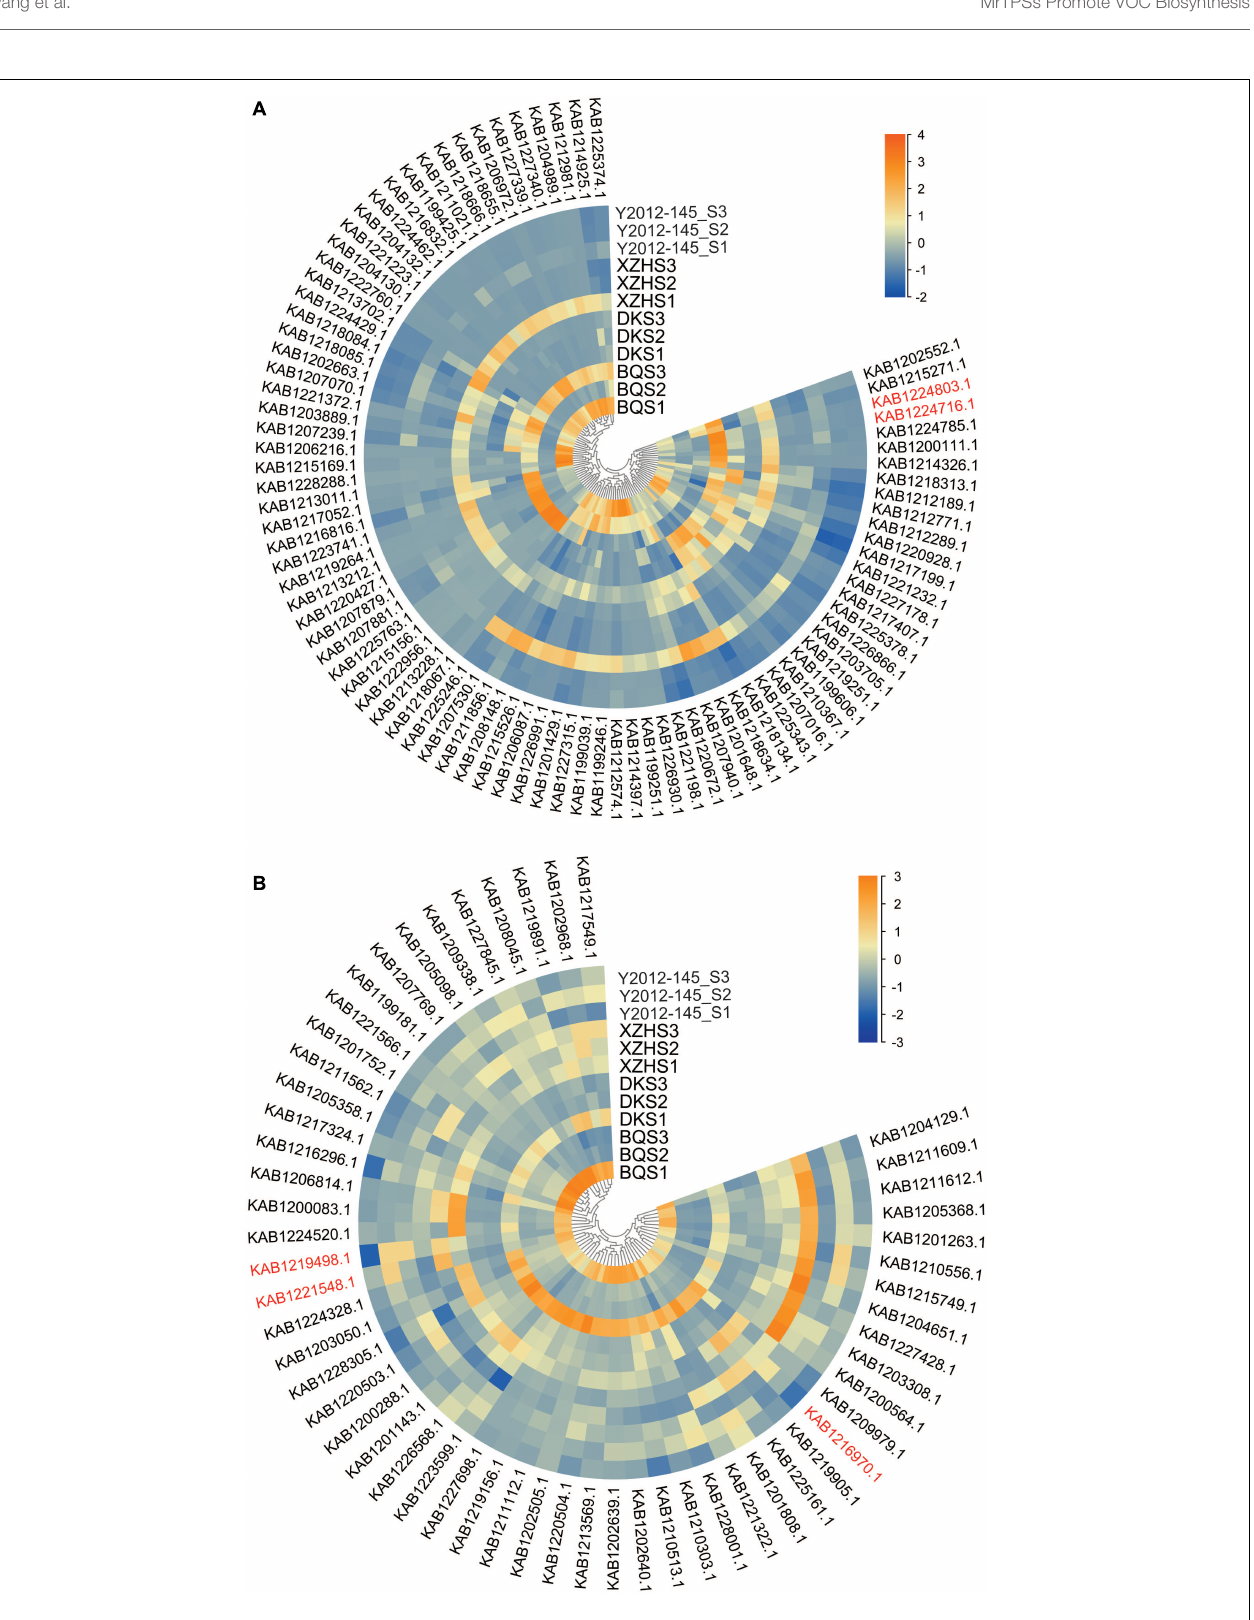
FIGURE 2 | Expression profiles of the selected gene set. (A) Expression files of genes that were specifically downregulated in ‘Biqi’ and ‘Dongkui.’ (B) Expression files of genes that were specifically downregulated in ‘Xiazhihong’ and ‘Y2012-145.’ Gene IDs in red font indicate the genes mentioned in the main text. Genes were clustered according to their expression